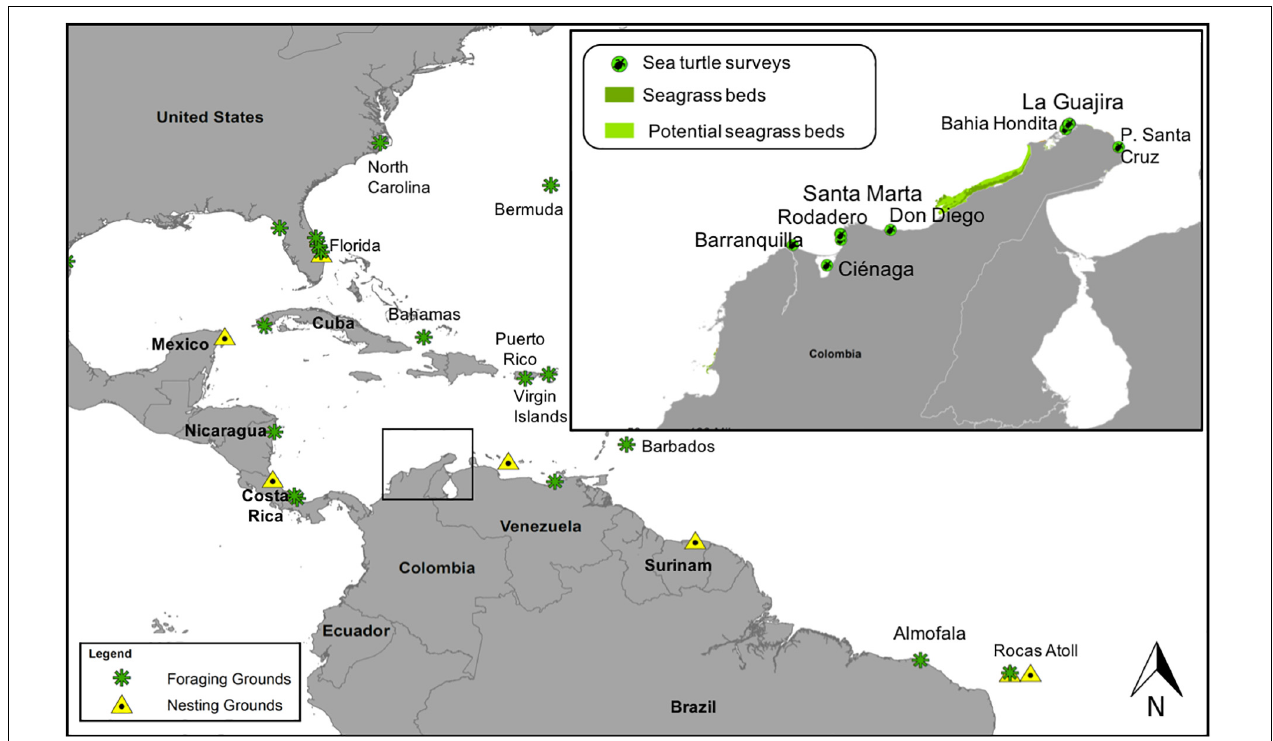
FIGURE 1 | Location of two Chelonia mydas foraging grounds in northeastern Colombia, southern Caribbean Sea (square), Santa Marta, and La Guajira. Specific survey sites and the location of C. mydas nesting rookeries (yellow triangles) and other foraging grounds (green asterisks) are shown in the Atlantic Ocean (references at Supplementary Table 1